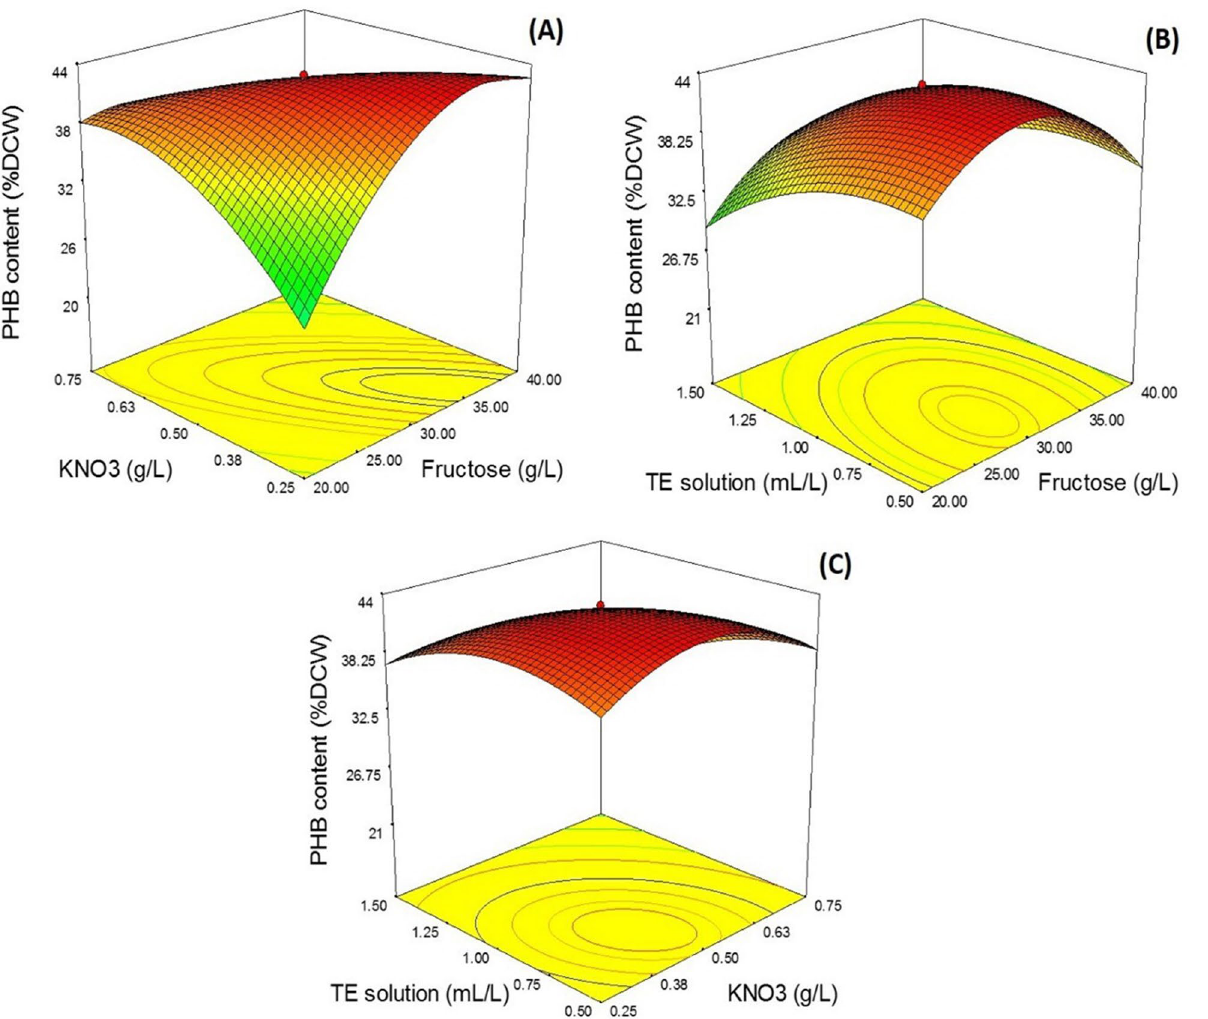
Figure 3. Response surface and contour plots described by the model, representing poly-β-hydroxybutyrate (PHB) accumulation (wt% DCW) as a value of fructose, KNO 3 , and TE solution by Rhodococcus pyridinivorans BRST1-1. Combined effect of fructose and KNO 3 ( A ); fructose and TE solution ( B ); KNO 3 and, TE solution ( C ).